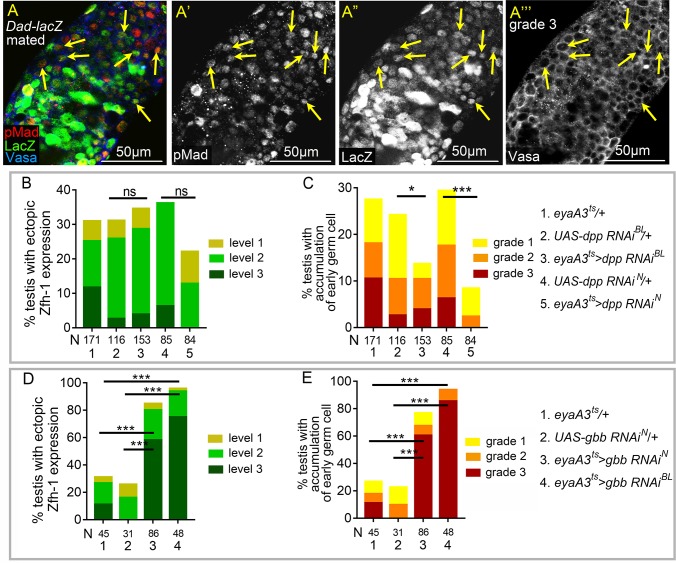
dpp-dependent BMP signaling activation in germ cells by reproduction.(A-A”‘) A grade 3 Dad-lacZ testis from mated male immunostained for pMad (red in A, and white in A’), co-stained for β-galactosidase (green in A, and white in A”), and Vasa (blue in A, and white in A’”). Arrows indicate the small germ cells positive for both pMad and LacZ. (B and C) Knockdown of dpp in cyst lineage cells decreased the percentages of germ cell accumulation (C), but did not significantly suppress ectopic Zfh-1expression (B). (D and E) Reducing gbb from cyst cell lineage failed to suppress ectopic Zfh-1 expression (D) and expansion of early germ cells (E) in mated testes. All p-values were calculated with Chi-squared test. ns: p>0.05, *p<0.05, **p<0.01, and ***p<0.001. Mass-mating was conducted for all experiments.